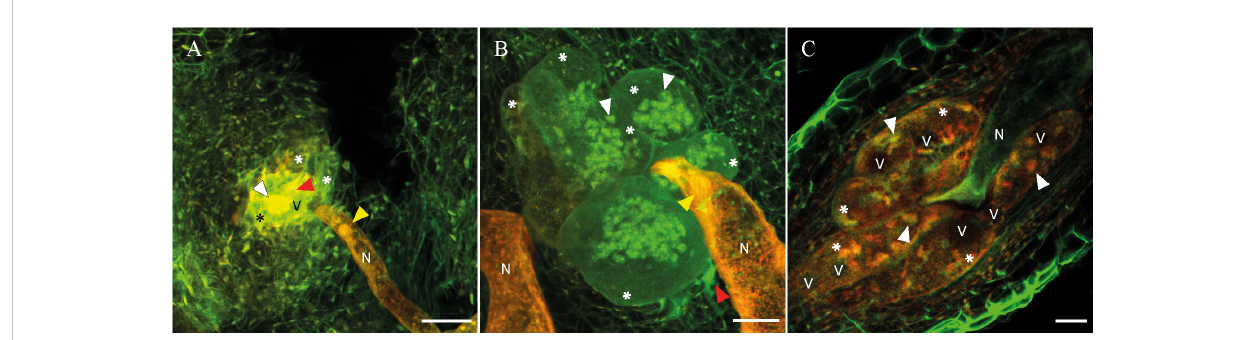
FIGURE 2 Laser scanning confocal microscope images of the infection site of Meloidogyne incognita 15 days after inoculation in the resistant Citrullus amarus BGV5167 (A) , and the susceptible cultivars watermelon cv. Sugar Baby (B) and pepper cv. Tinsena (C) . Nematode (N), vacuoles (V), giant cells (asterisk), some nuclei (white arrowhead), necrosed area (red arrowhead), and esophageal median bulb (yellow arrowhead) are indicated. Scale bar: 50